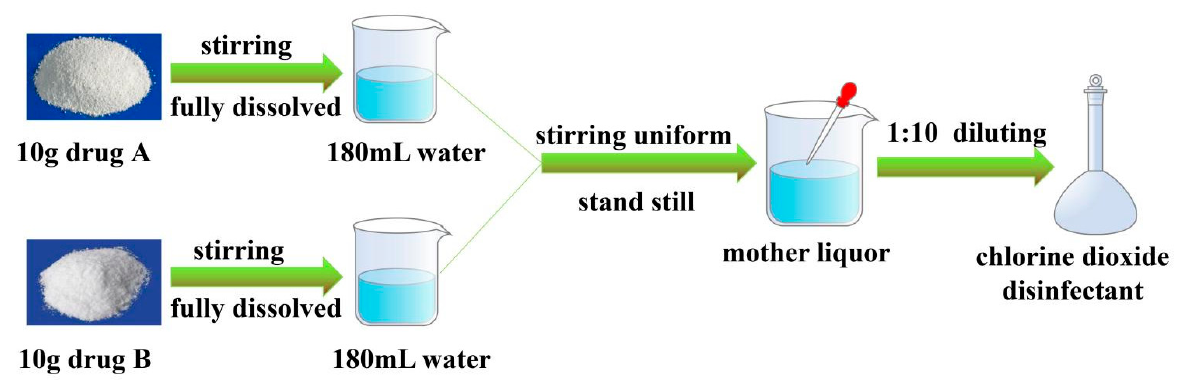
Figure 2. The preparation process of chlorine dioxide disinfectant.